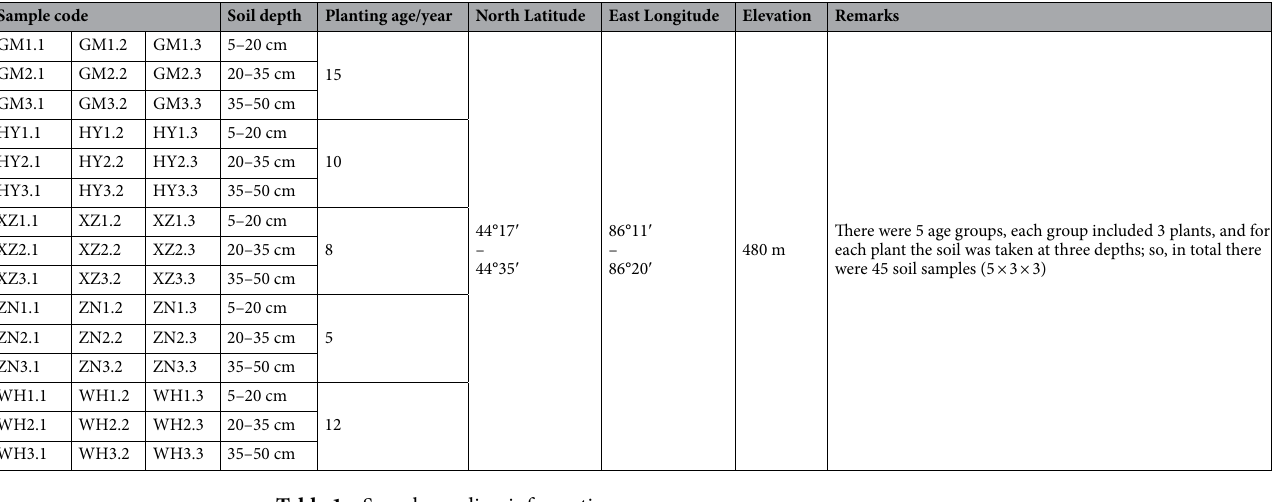
Table 1. Samples coding